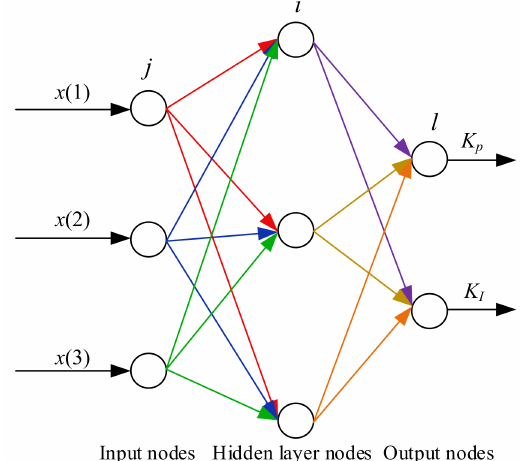
Figure 7. PI controller based on BP neural network.